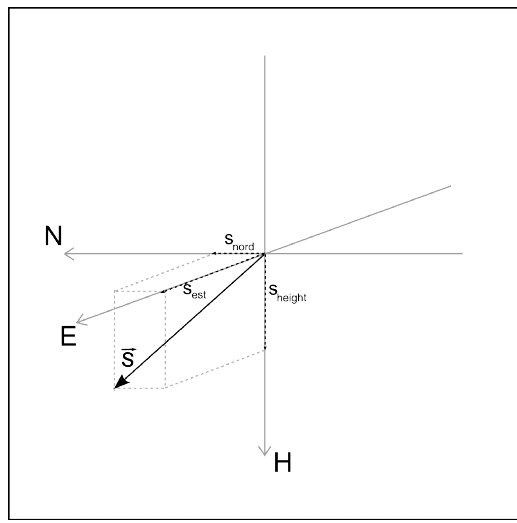
measurements.Figure 5: Satellite unit vector